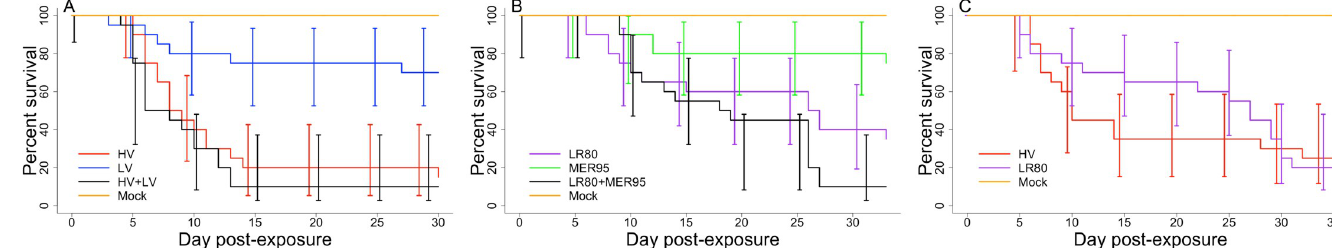
Fig 1. Cumulative survival of fish exposed to IHNV. Panels show Kaplan-Meier survival curves for fish exposed to IHNV genotypes HV (red), LV (blue), MER95 (green), LR80 (purple), mixed infections (black, 1:1 ratio of two genotypes in experiment), or a mock negative control (orange) in experiments 1–3 (A-C, respectively). Mixed infections were not assessed in experiment 3. Error bars show 95% confidence interval based on cumulative hazard, derived from Kaplan-Meier analyses. All treatments began with 20 fish, with the exception of mock control which had 8 fish. Mortalities were recorded daily for the entire course of the experiment (30–35